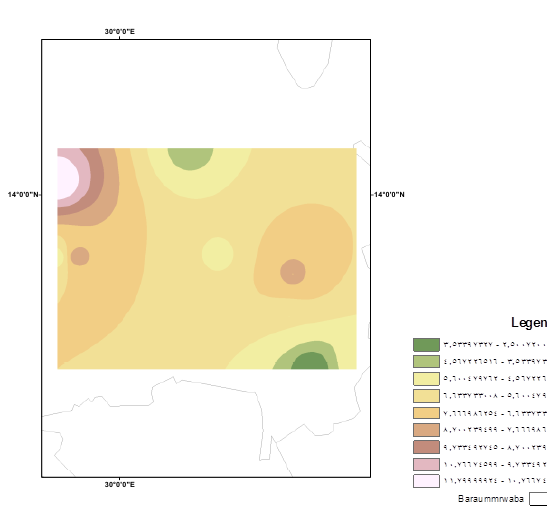
Fig 7.N-Kordofan, Bara- δ18O-nitrate distribution Using IDW Interpolation